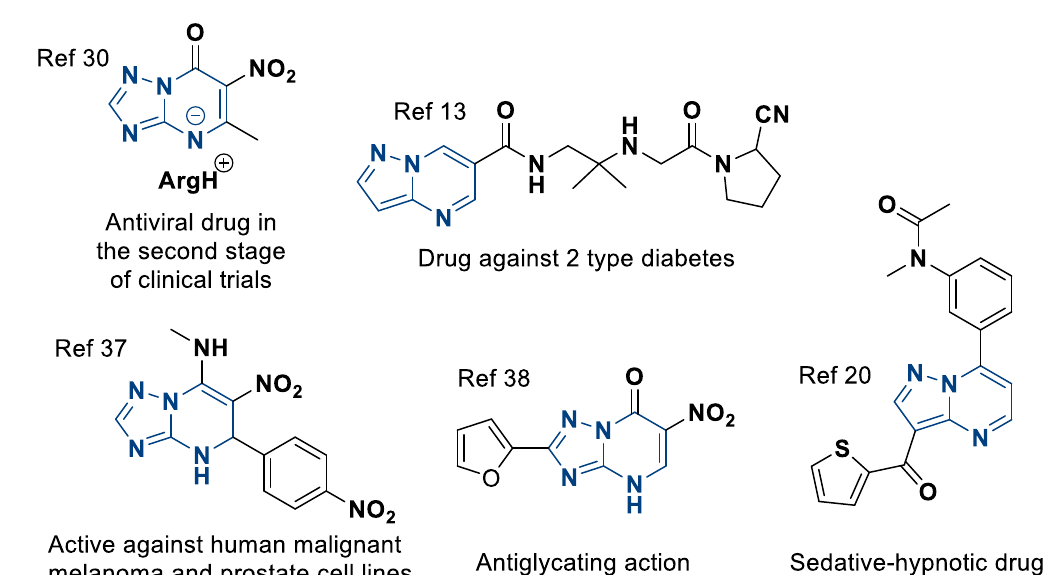
Figure 1. Examples of biologically active